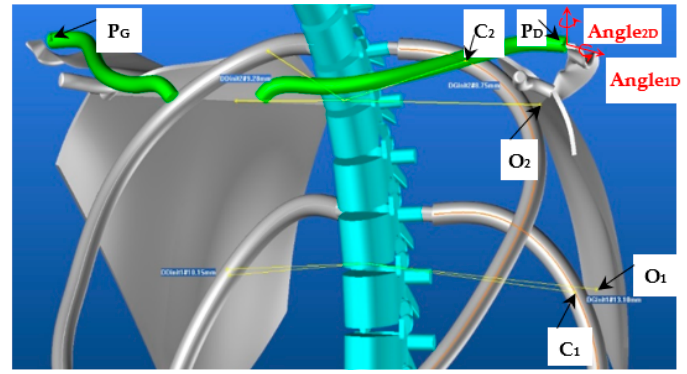
Figure 17. The scapula orientation mark and control points. Figure 18 represents the evolution curves of the different angles as a function of the corrections to be made to the DCinitx distances.